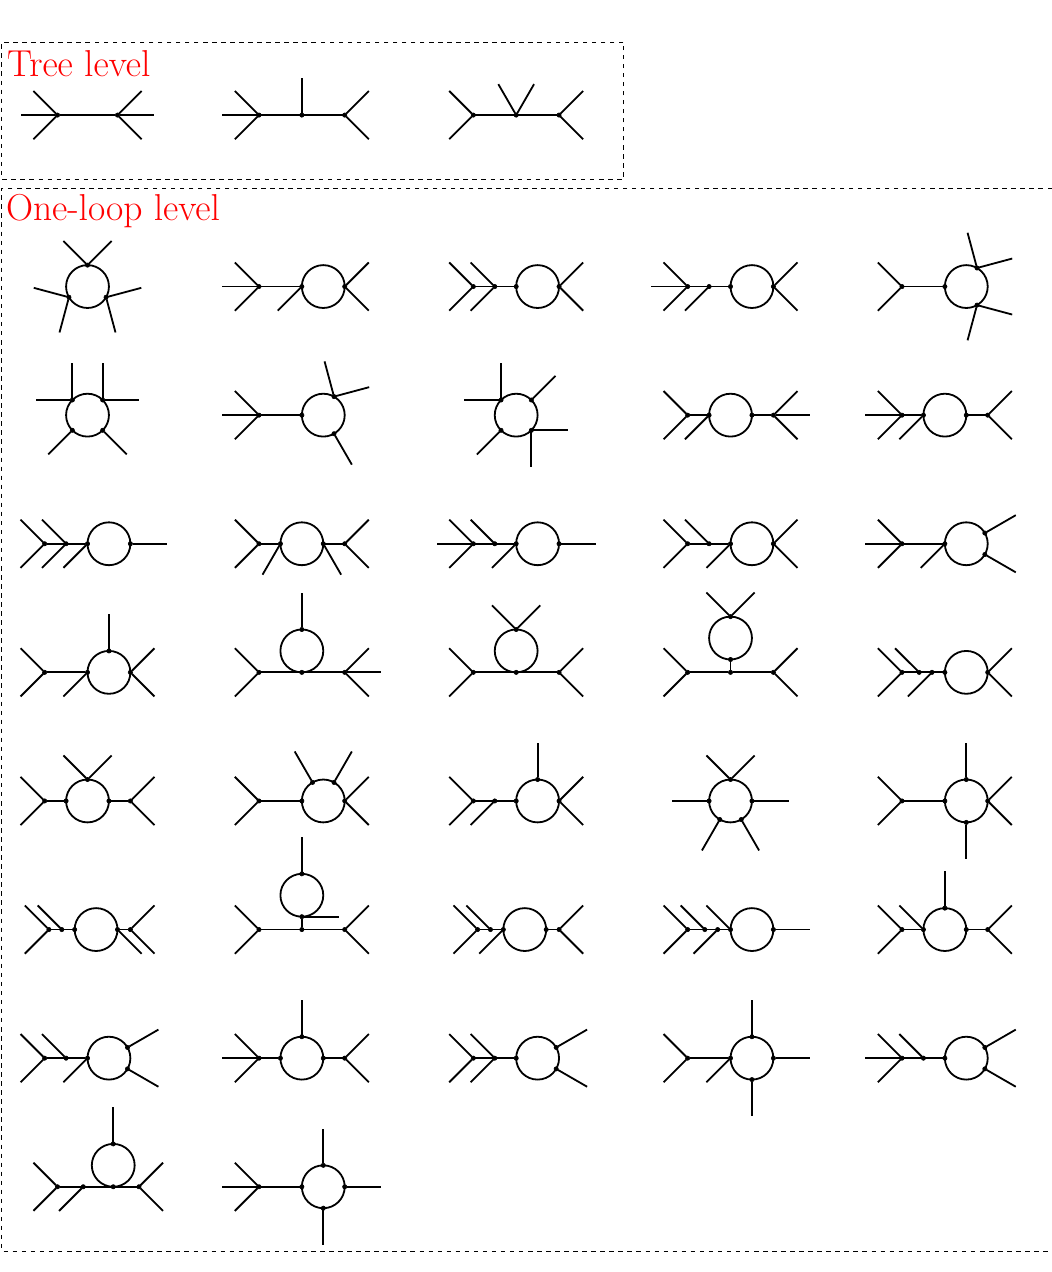
Figure 14 . The non-renormalizable tree-level and one-loop